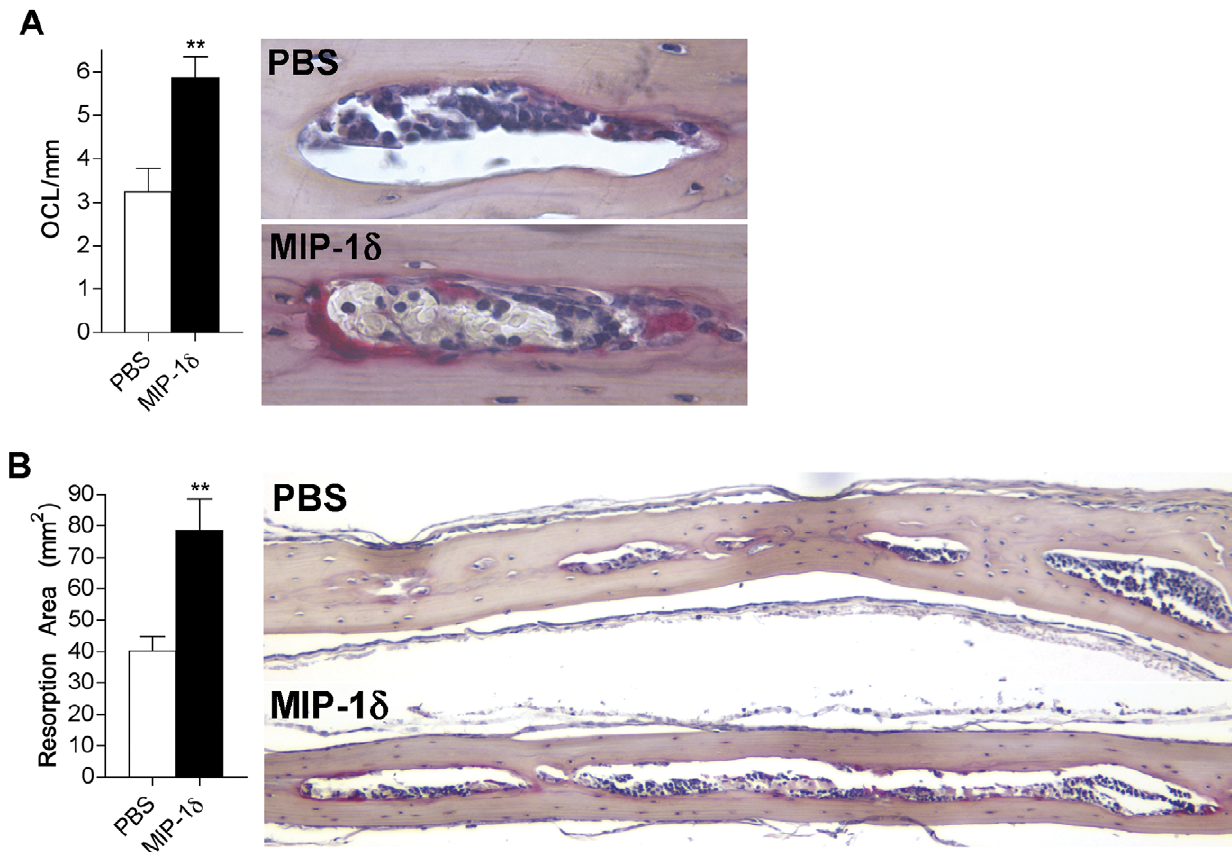
Figure 4. MIP-1 d promotes osteoclastogenesis and bone resorption in vivo. Mice (5/group) were administered MIP-1 d (1 ng/ml) or PBS subcutaneously over the calvariae twice each day for 5 days. Calvariae were removed and paraffin-embedded sections were generated for histomorphometric analysis. (A) OCL were identified by TRAP staining, counted under light microscopy (right, 400X), and reported relative to mm of marrow cavity surface (left). (B) Resorption area (left) was determined by measuring the total area occupied by marrow cavities within each calvarial section (right, 100X). Data are representative of two independent experiments, expressed as the mean (n =10) 6 s.e.m, and were analyzed by unpaired, two-tailed Student’s t-test. **, p , 0.01.